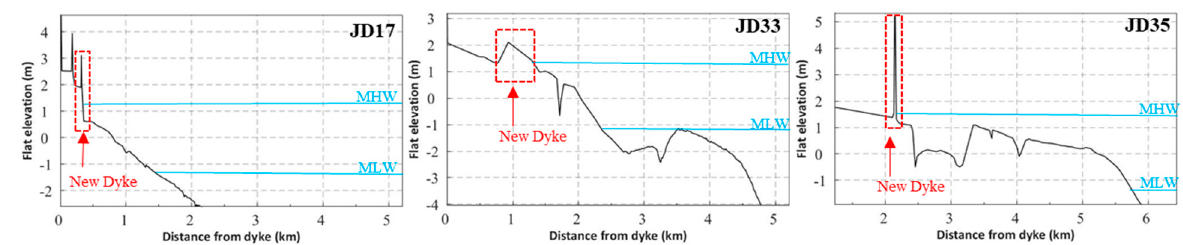
Figure 12. Zoom in on the bed elevation in front of and behind the newly built dykes (note that the scales of the three panels are not uniform).